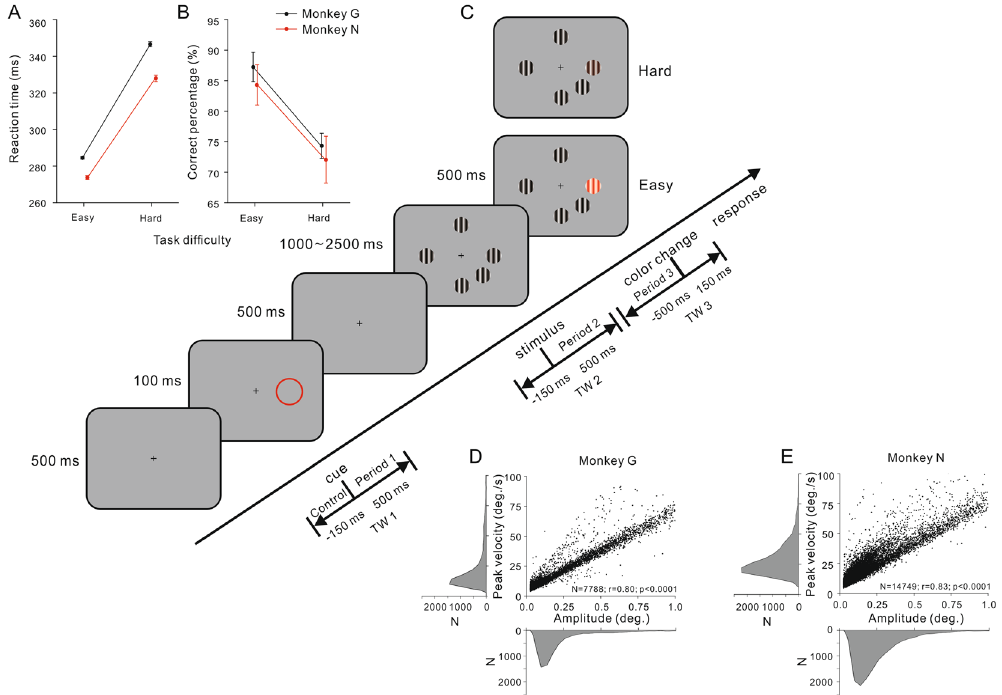
Figure 1. Task paradigm, behavioral performance and main sequences. ( A , B ) Changes in RT (left column) and response accuracy (right column) while performing tasks under different difficulties by monkey G (black) and monkey N (red). ( C ) Illustration of the experimental paradigm. Two rhesus monkeys were trained to fixate on a small cross while covertly attending to a spatial location that was cued 100 ms after the beginning of each trial. The cue was a thin red ring. After the cue ring disappeared for 500 ms, five drifting gratings were presented at iso-eccentricity locations. The grating that appeared at the cued position changed color after a random interval, and the animal was tasked with detecting the change by releasing a bar within 500 ms. The perceptual load modulations on microsaccades were measured in three different time windows (TWs) and four time periods. The Control period (150 ms before the cue onset) was defined as the baseline of microsaccade activities. The others were defined as 500 ms after the onsets of the cue and the stimulus and 500 ms preceding the color change. ( D , E ) Main sequences. Main panels: Peak velocity as a function of the microsaccade amplitude, including all microsaccades of monkey G and N. Each black dot corresponds to a single microsaccade. Bottom and side panels: Distributions of the microsaccade amplitude and peak